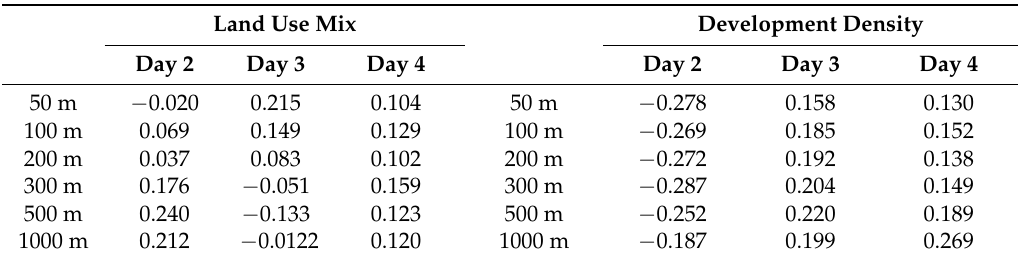
Table 8. Pearson’s R correlation between land use mix and development density and personal exposure to PM 2.5